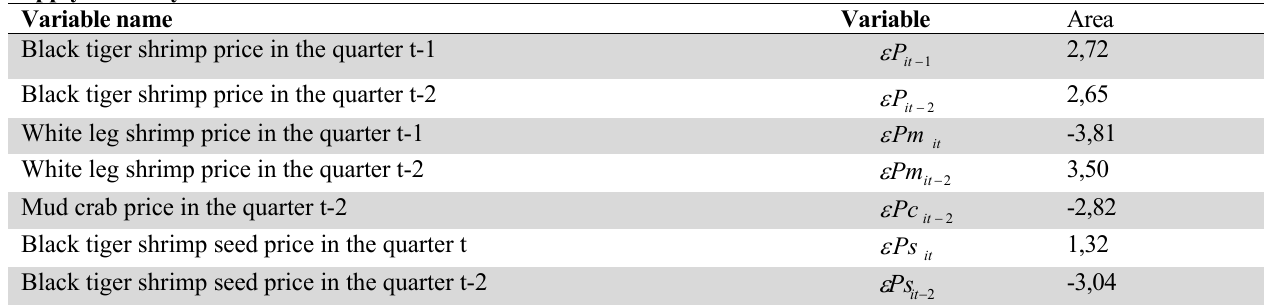
Supply elasticity in